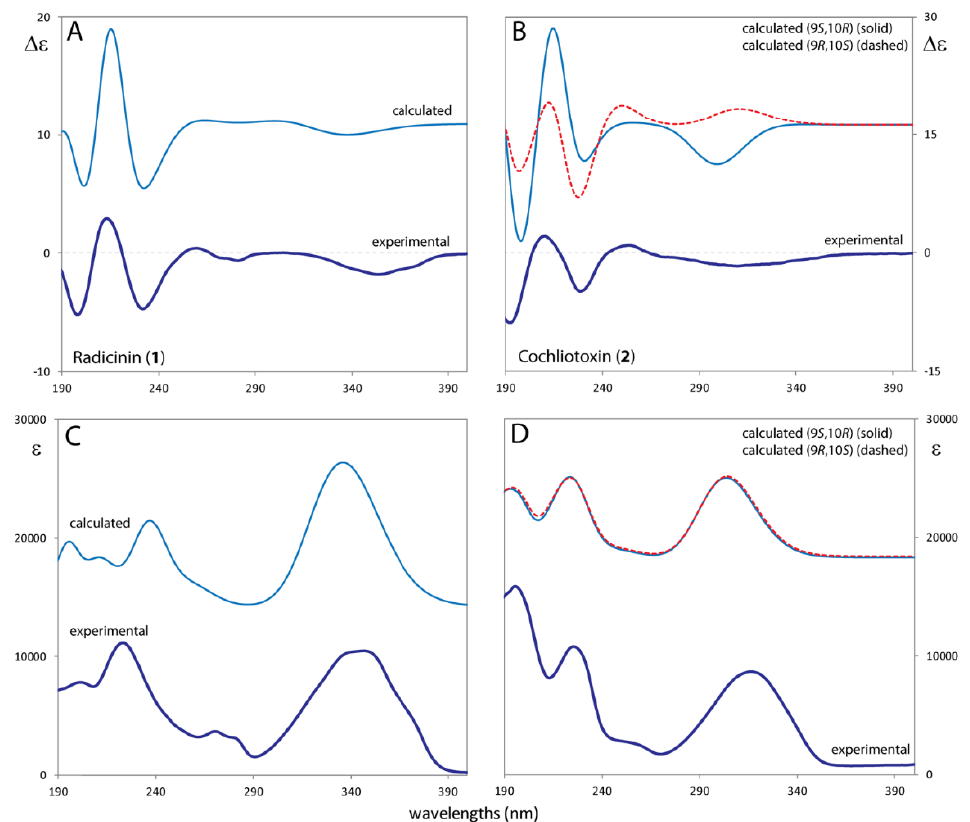
Figure 5. Comparison of experimental and calculated Electronic Circular Dichroism (ECD) and UV spectra of radicinin ( 1 ) (panels A , C ) and of cochliotoxin ( 2 ) (panels B , D ). For ( 2 ) the two possible diastereomers have been calculated. TD-DFT/CAM-B3LYP/aug-cc-pVDZ/PCM(ACN) level of theory. Calculated spectra are red-shifted by 15 nm and divided by factor 3.